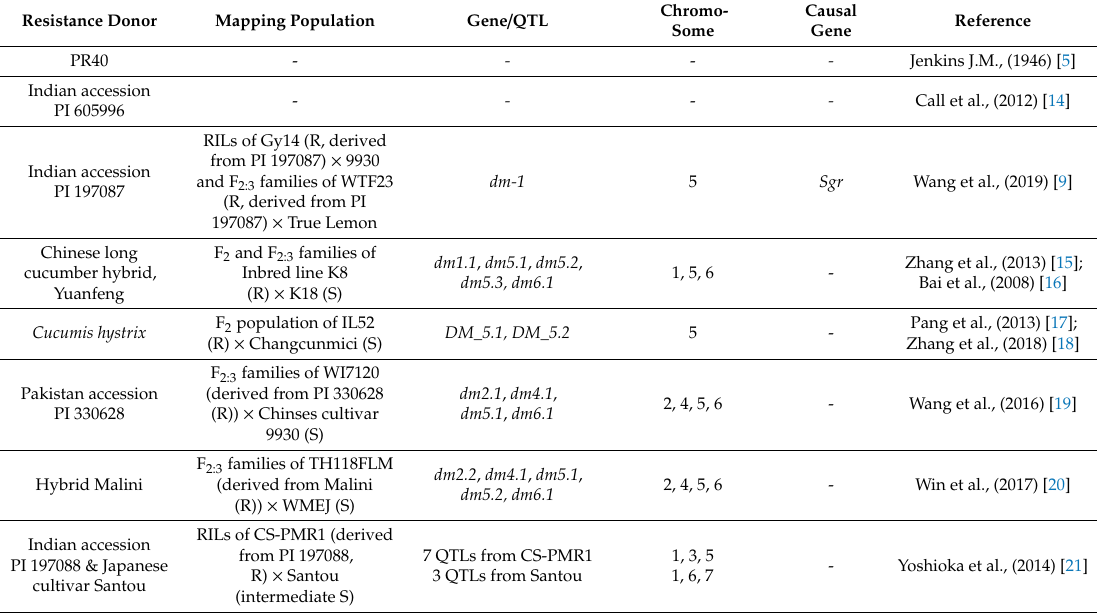
Table 1. Overview of mapped and cloned genes / quantitative trait loci (QTLs) for downy mildew resistance in